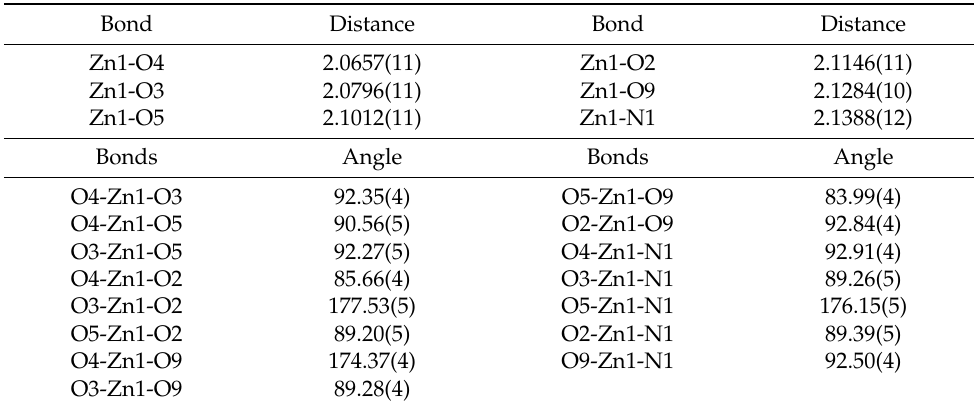
Figure 4. The asymmetric unit of [Zn(DiEtNA)(H 2 O) 4 (SO 4 )] · H 2 O ( 2 ). The disorder of one of the ethyl groups was refined as Part 1 (59.7%) and Part 2 (40.3%). Table 2. The important geometric parameters (Å, ◦ ) in complex 2